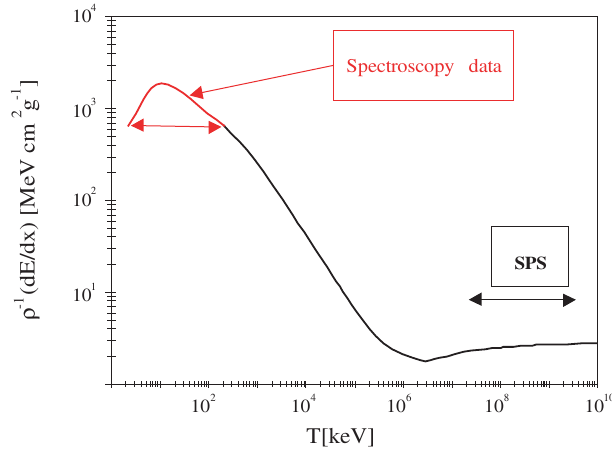
FIG. 1. (Color) Energy loss scaling from the energy range ex- plored in spectroscopy to the